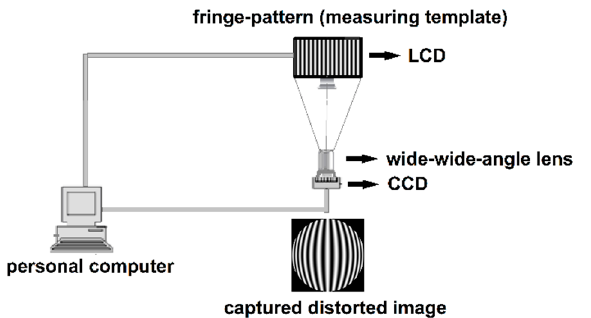
Figure 9. Experimental setup. Liquid crystal display (LCD): FunTV D49Y; wide-angle lens: Theia MY125M, FOV137 0 ; charge-couple device (CCD) camera: PointGrey CM3-U3-50S5M-CS, 2048 × 2448 pixels, 3.45 μ m pixel size.